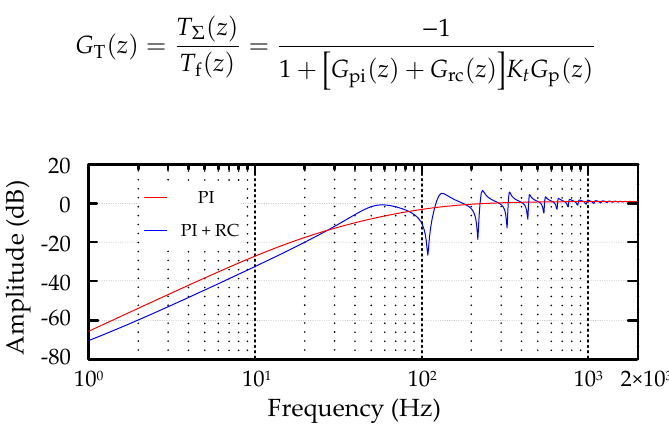
Figure 11. The amplitude-frequency characteristic curves of